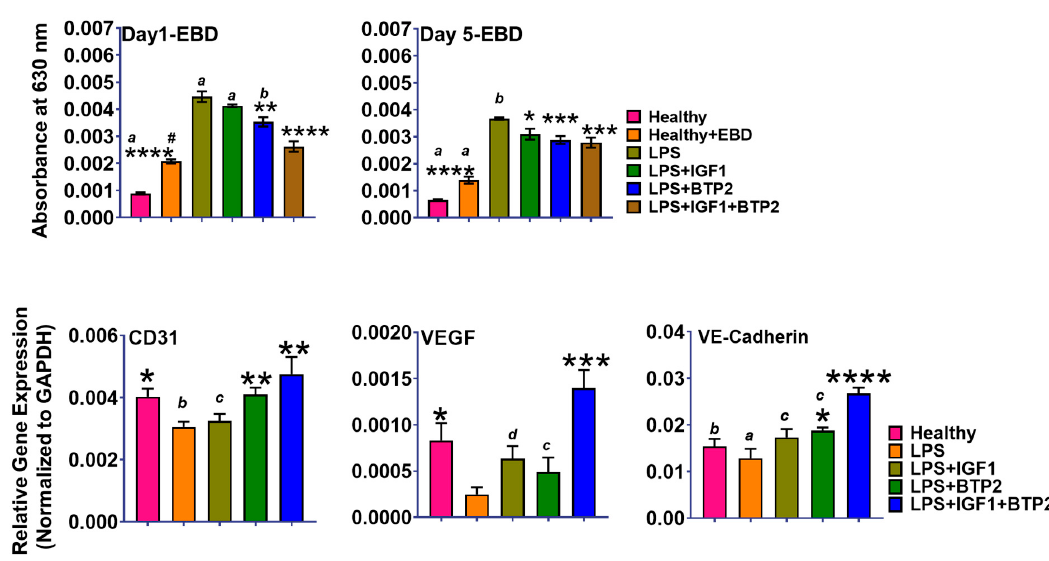
Figure 6. Favorable effects of therapies on LPS induced changes in vascular integrity in AKI mice. Evans blue dye measurements of vascular leakage in the kidney (Upper panel). CD31, VEGF, and VE-Cadherin, all angiogenic markers (lower panel). See text for interpretation. Data are mean ± SEM * p < 0.05, ** p < 0.01, *** p < 0.001, **** p < 0.0001 (LPS Vs other groups) and d - p < 0.05, c - p < 0.01, b - p < 0.001, a - p < 0.0001 (LPS + IGF1 + BTP-2 Vs other groups), 1-way ANOVA followed by a Dunnett’s multiple comparisons test, ( n = 4 in each group).